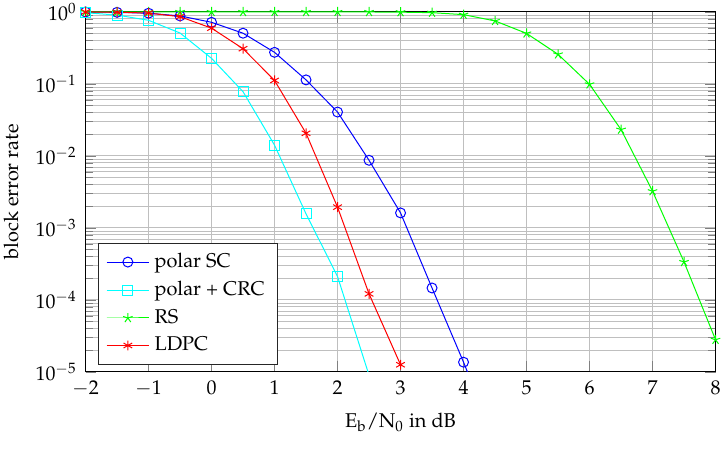
Figure 3. Block error